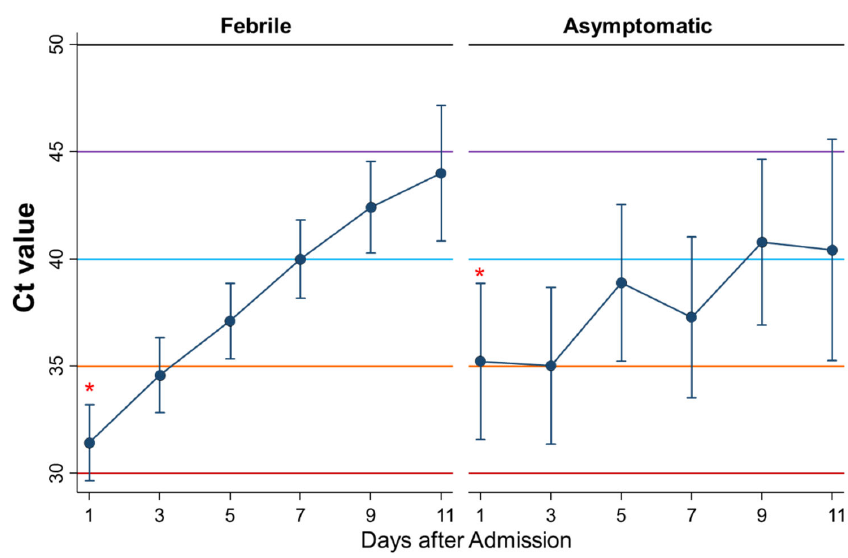
Figure 5. Differential changes of Ct values between febrile and asymptomatic patients. Mean Ct with 95% confidence intervals. When the Ct value is 40 or more, the PCR-test result is considered negative. * represents a significant difference ( P < 0.05 ).